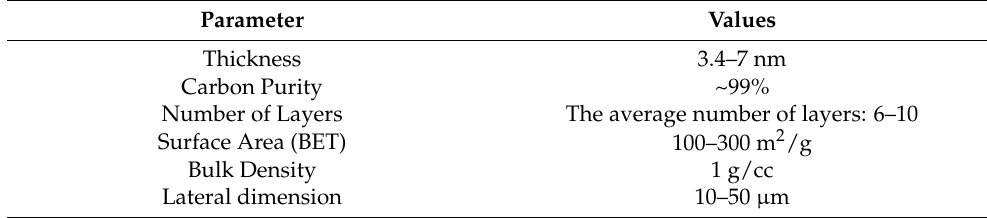
Table 1. Characteristics of commercial graphene oxide